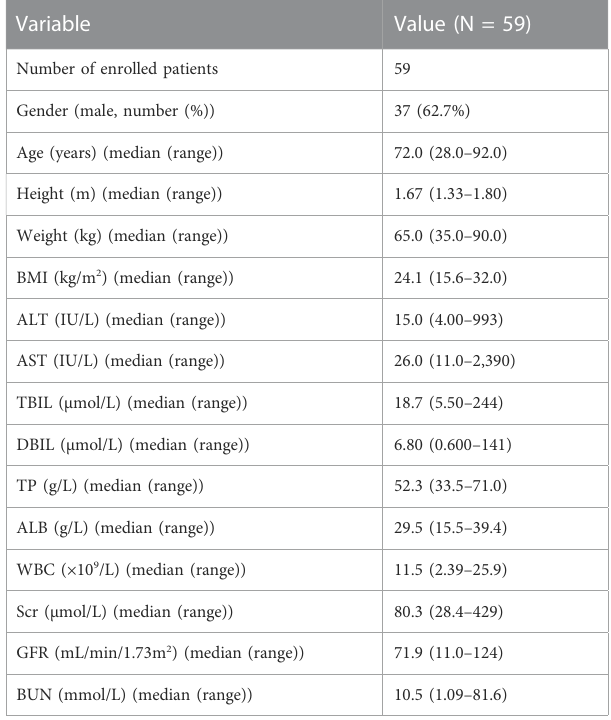
TABLE 1 Characteristics of the